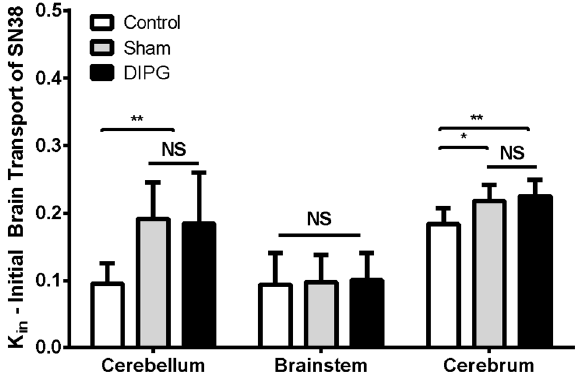
Figure 6. Comparison between control (non-operated), sham, and DIPG cell-derived xenografts of the initial brain transport (Kin; µL s -1 g -1 ) of [ 3 H]-SN-38 within the cerebellum, brainstem, and cerebrum, measured by in situ brain perfusion using 8-week-old RH-Foxn1rnu rats. Results are expressed as mean ± S.D. (n = 7–10 animals per group). One-way ANOVA, NS: no statistical difference, * p < 0.05, ** p < 0.01.